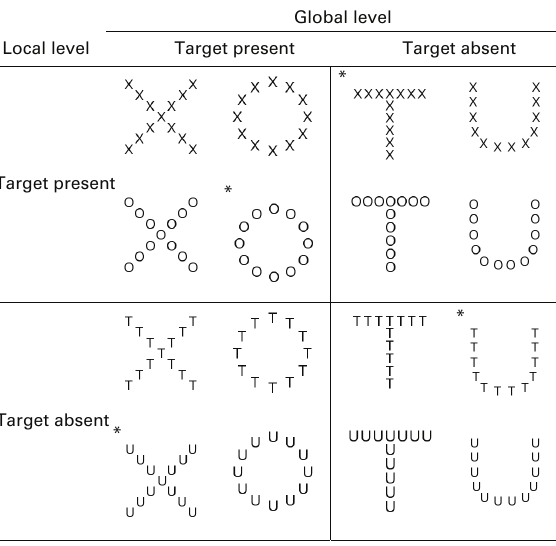
figure appeared in the left visual field RH than in the right visual field LH. Conversely, local-level targets were processed more quickly when the hierarchical figure was presented cen- trally or in the right visual field LH in comparison to the left visual field RH. Sergent (1982) interpreted this pattern as evi- dence that global information is preferentially processed in the RH and that local information is preferentially processed in the